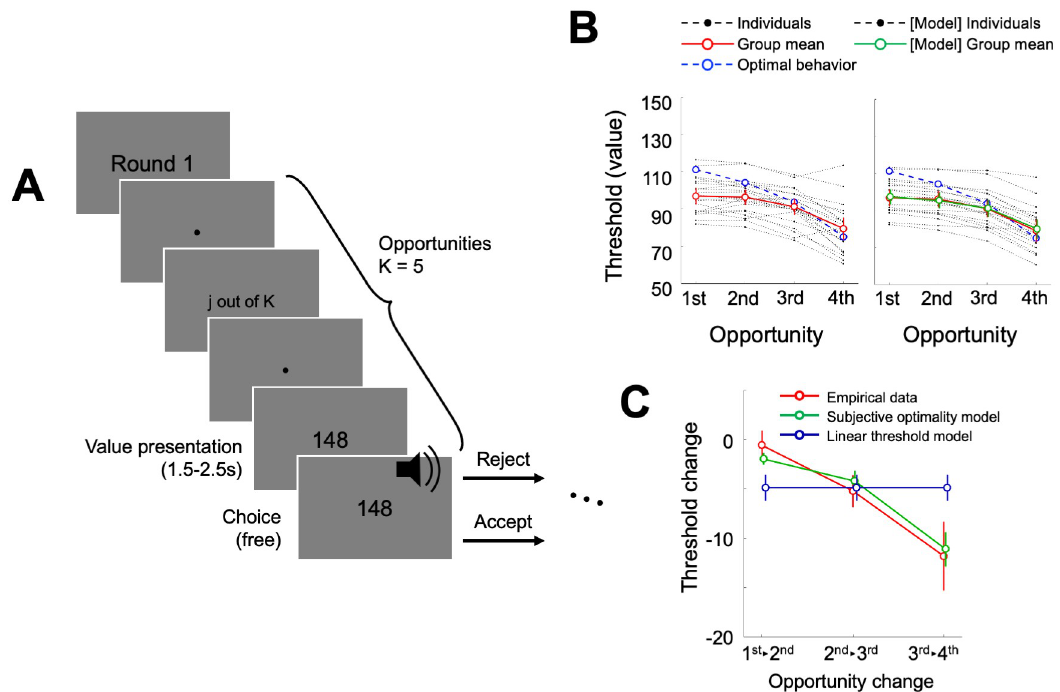
Fig 4. Experimental procedures and behavioral results of Experiment 3. (A) To temporally dissociate valuation from action selection, we implemented a modified task design where individuals had to wait for an audio cue to make choices. (B) Empirical decision thresholds (red) were compared with the optimal decision thresholds (blue). Compared with Experiments 1 and 2, in Experiment 3, individuals showed lower decision thresholds at the early opportunities. Error bars represent s.e.m. (C) The pattern within the decision curve (change in the slope of decision threshold) was consistent in Exp 3 data, and our Subjective optimality model successfully explained the pattern (differences between the model and empirical data do not vary across opportunities; F(2, 40) = 1.80, η 2 = 0.082, p = 0.18), and has superior explanatory power to the linear threshold model. Negative values on the y-axis indicate that decision thresholds decrease between opportunities. Error bars indicate